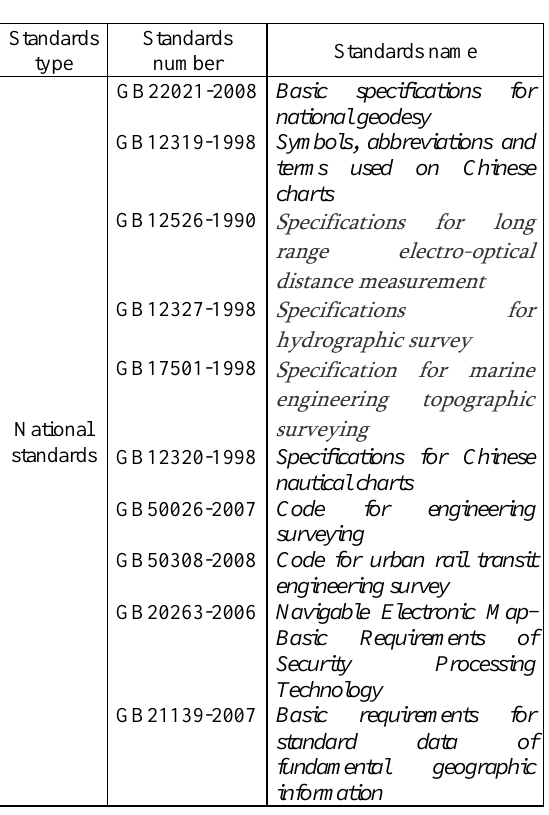
Table 3 . Some basic national standards in "Surveying and Mapping Standard System